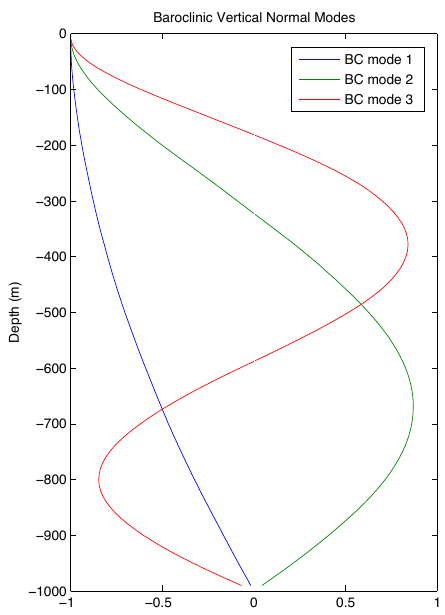
Fig. 4. Quasi-geostrophic normal modes computed from the mean N 2